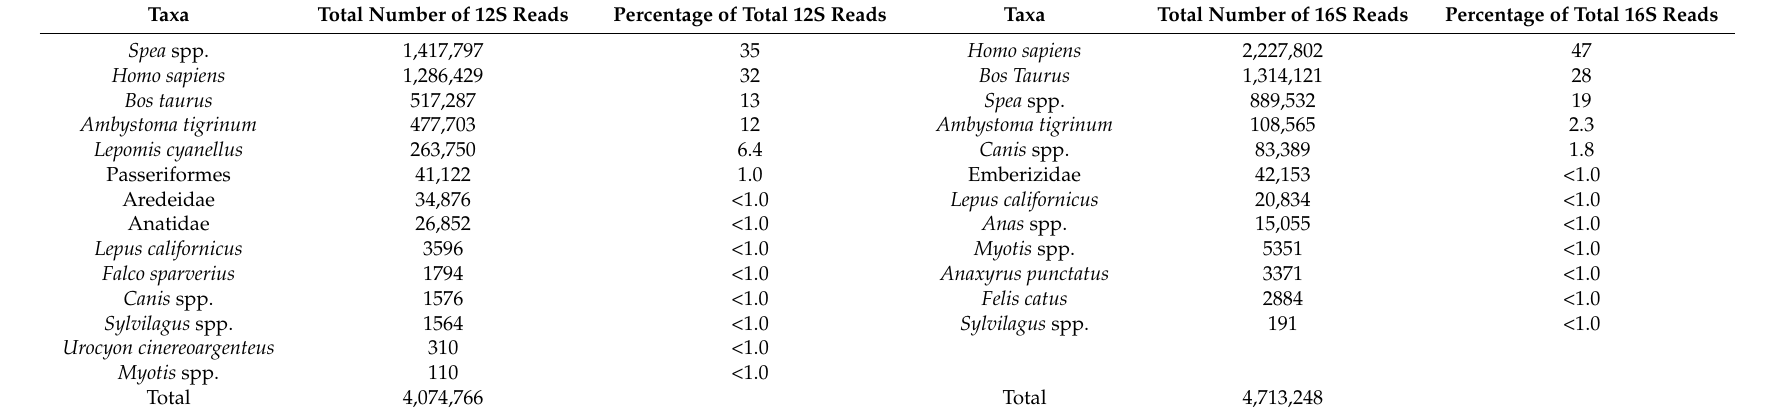
Table 5. Percentage of reads per field detected taxon for each marker after removal of lab contaminant reads and singletons. Taxa Total Number of 12S Reads Percentage of Total 12S Reads Taxa Total Number of 16S Reads Percentage of Total 16S Reads Spea